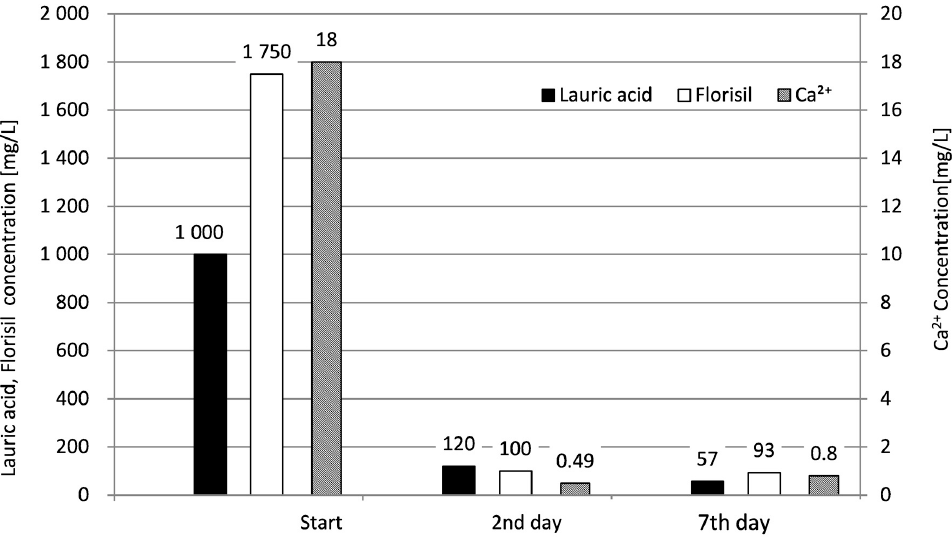
Figure 5. Comparison of water quality analytical findings for Case L & F (lauric acid and florisil) for di ff erent days. Table 4. Average of water quality results.